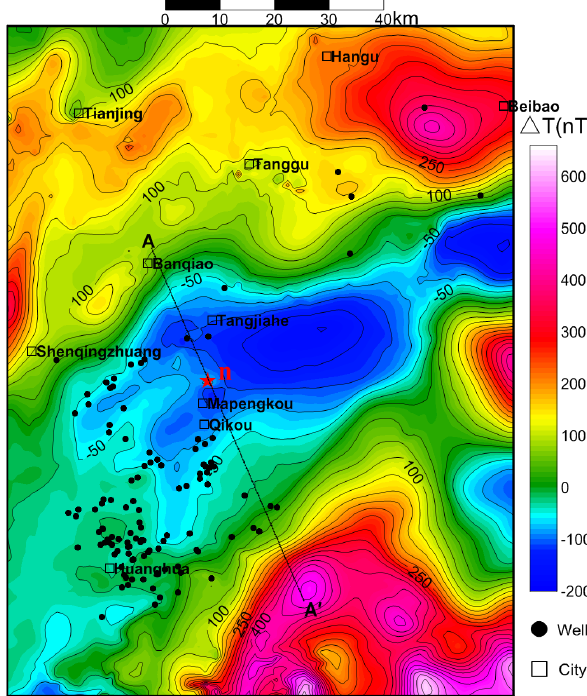
Fig. 7. The RTP magnetic anomalies of our study area; A–A 0 is the location of the magnetic anomaly profile in Fig. 12 and n indicates the location of the plot in Fig. 9.